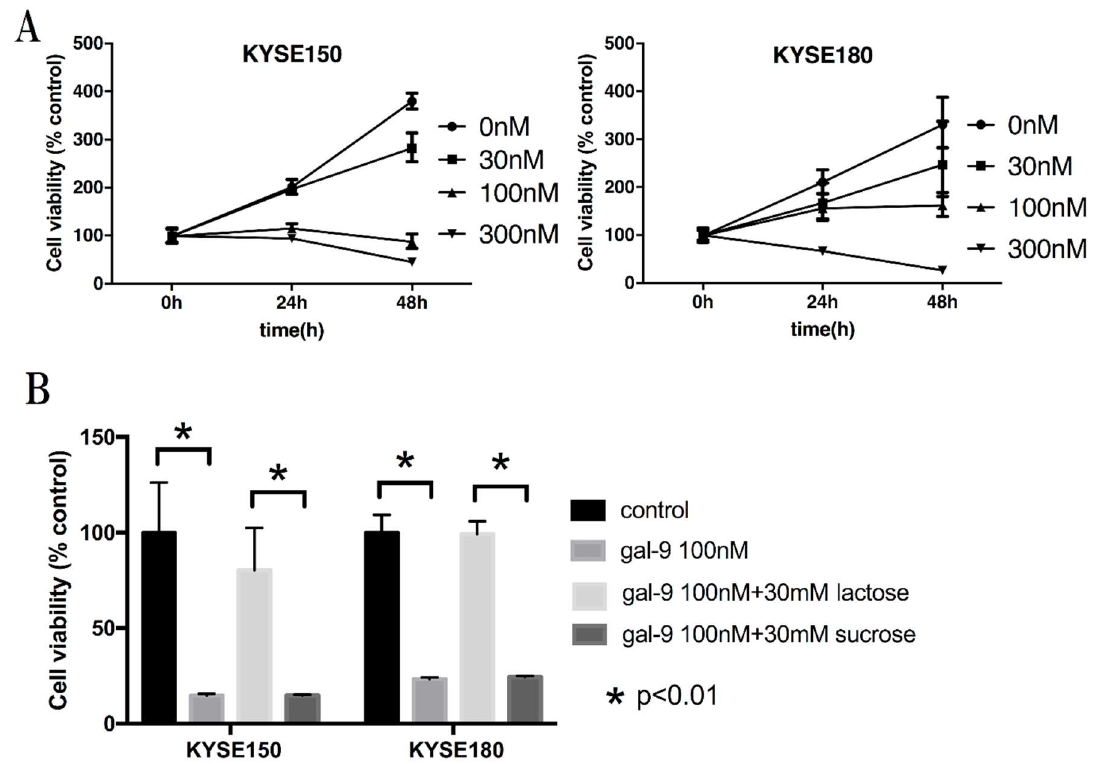
Figure 1. Galectin-9 (Gal-9) suppresses the proliferation of esophageal squamous cell carcinoma (ESCC) cells in vitro. ( A ) Human ESCC cell lines (KYSE-150 and KYSE-180) were treated with Gal-9 (30, 100, and 300 nM) and the cell viability was measured with Cell Counting Kit-8 after 24 and 48 h. The tumor cell proliferation was significantly suppressed in a time- and concentration-dependent manner. The results are expressed as the percentage of viable cells relative to the control cells (0 nM); ( B ) The effect of Gal-9 was antagonized by 30 mM lactose in both KYSE-150 and KYSE-180 cells in 48 h, suggesting that the β-galactoside–binding properties of Gal-9 are essential for its activity. The error bars represent 95% confidence interval (CI).